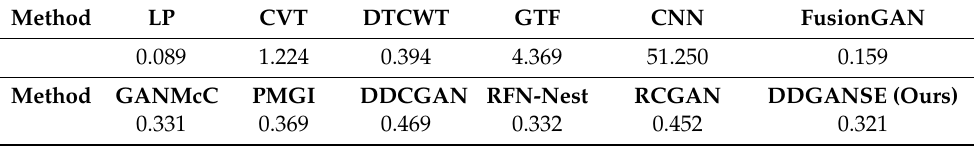
Table 4. Average running times of different methods (unit: second).